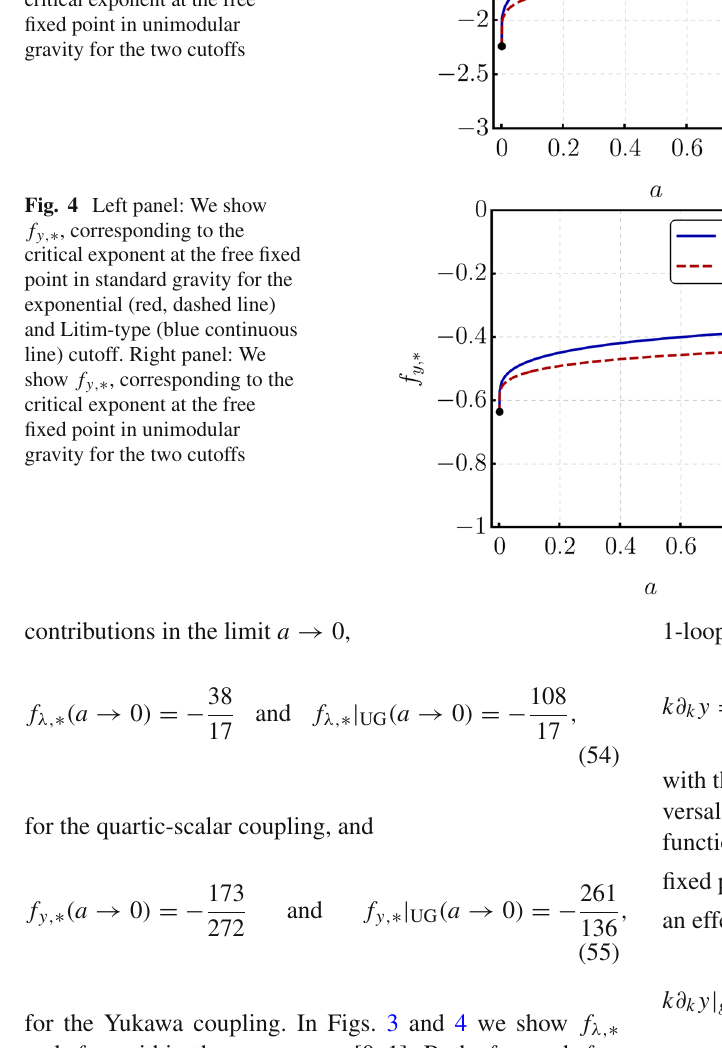
Fig. 3 Left panel: We show f λ, ∗ , corresponding to the critical exponent at the free fixed point in standard gravity for the exponential (red, dashed line) and Litim-type (blue continuous line) cutoff. Right panel: We show f λ, ∗ , corresponding to the critical exponent at the free fixed point in unimodular gravity for the two cutoffs